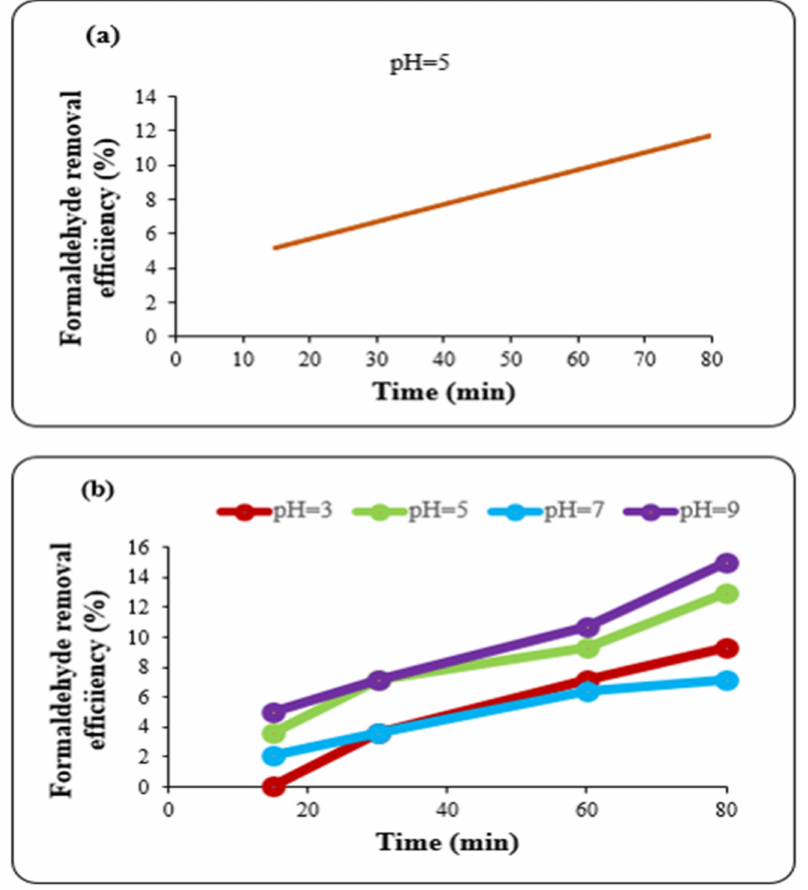
Figure 1. ( a ) Effect of photo-Fenton on the formaldehyde removal at pH 5. ( b ) The results of ozonation in the formaldehyde removal at different pH and contact times. Ozone concentration = 1.4 mg/L min; formaldehyde concentration = 215.91